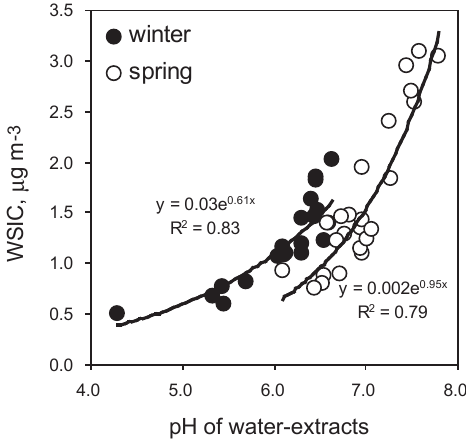
Fig. 1. Correlation of water-soluble inorganic carbon (WSIC) and Fig.1 Correlation of water-soluble inorganic carbon (WSIC) pH of water-extracts of the PM 10 samples during winter and spring. and pH of water-extracts in the PM 10 samples during winter and spring during winter, which are 1.5 times higher than those during spring (Table 1). Organic carbon (OC) is more abundant in winter than in spring, and also more abundant in the urban regions than in the suburban area. It may be due to more emissions of fossil fuel combustion at the urban area, espe- urban cially in winter when burning coal for house heating is very common. Elemental carbon (EC) in the urban aerosols is 17 ± 3 . 8 µg m − 3 in winter and 20 ± 5 . 9 µg m − 3 in spring, be- ing 2–3 times higher than those at the suburban sites. During winter OC/EC ratios are 4 . 5 ± 0 . 9 in the urban and 6 . 5 ± 0 . 9 in the suburban sites. On the other hand, OC/EC ratios in spring are 2 . 7 ± 0 . 7 and 3 . 4 ± 0 . 7 in the urban and suburban areas, respectively (Fig 2). The higher